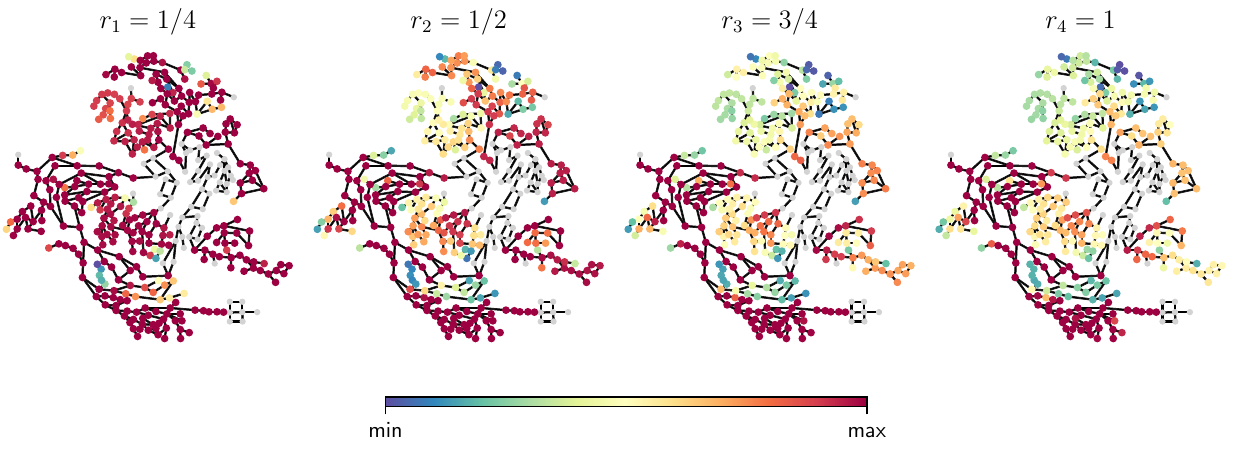
Figure 5. Mean resilience index ρ ( s ) for each node serving as the shelter node in the centralized sheltering scheme for all analyzed evacuation